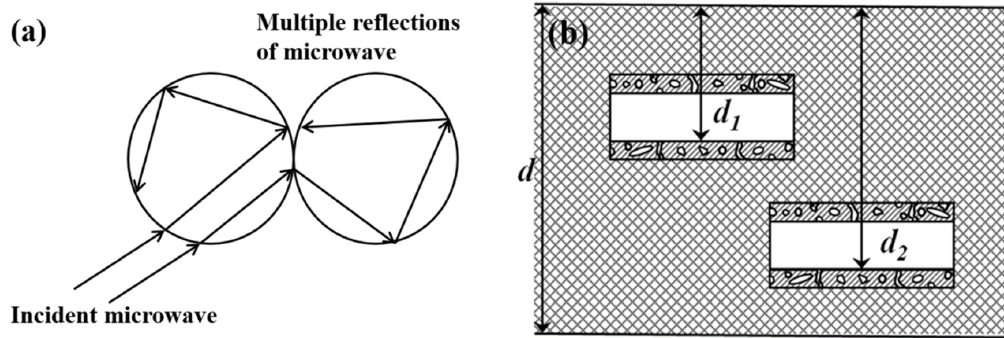
Figure 8. Effect of porous ( a ) and hollow ( b ) structures on microwave transmission and dissipation.